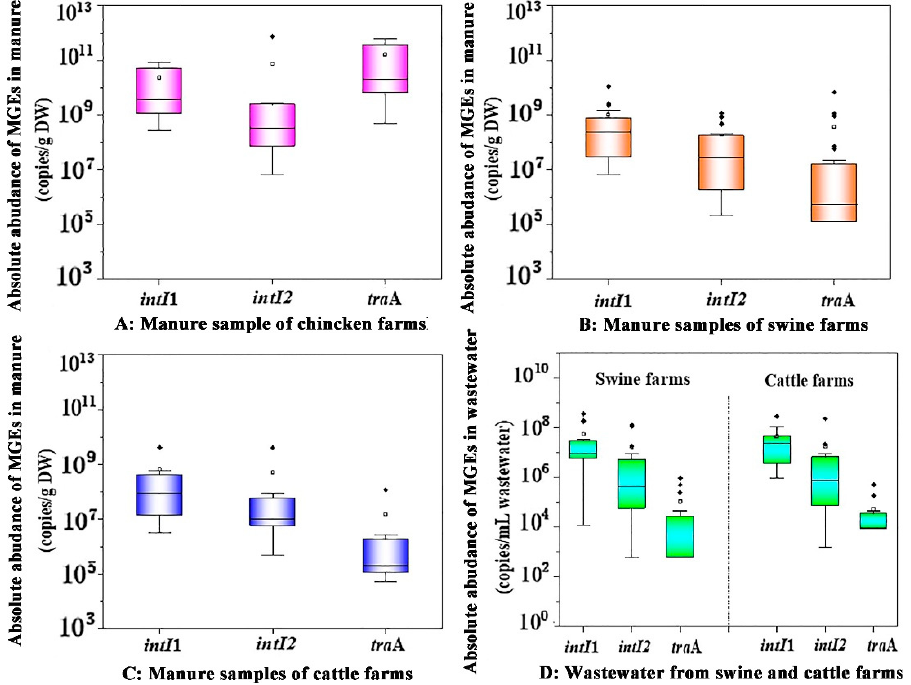
Figure 6. The absolute abundance of MGEs in livestock feces ( A – C ) and wastewater ( D ) from family farms. Solid points represent extreme outliers, that is, outliers more than three times the quartile distance; Hollow points represent milder outliers, that is, outliers between 1.5 and 3 quartiles.